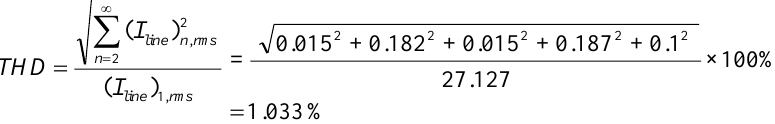
Table 1. Differentiation of the application of Boost PFC No. of predominant harmonic components THD Without the application of Boost PFC 12 47.48% With the application of Boost PFC 5